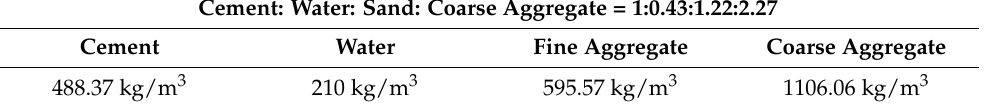
Table 1. Concrete mix proportion.